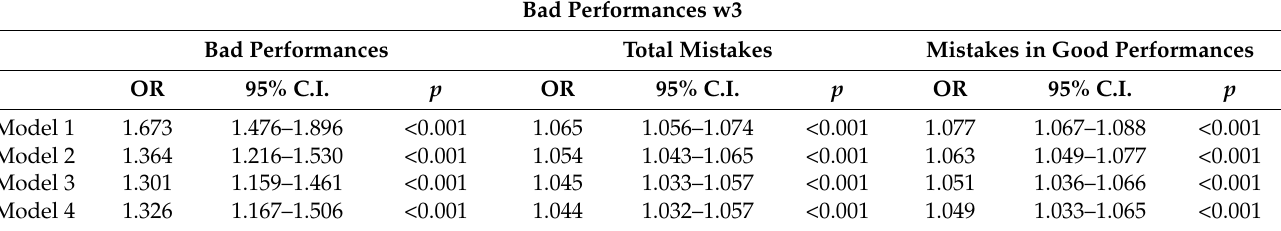
Table 3. Comparison of the OR and corresponding 95% C.I. of bad performances, total mistakes, and mistakes in good performances for the prediction of bad performances w3 in the binary logistic regression models.